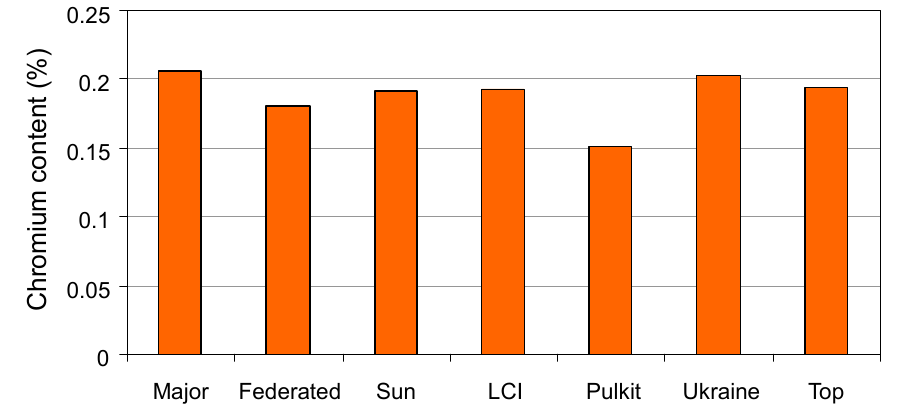
Fig. 6. Chromium(Cr) contents in steel